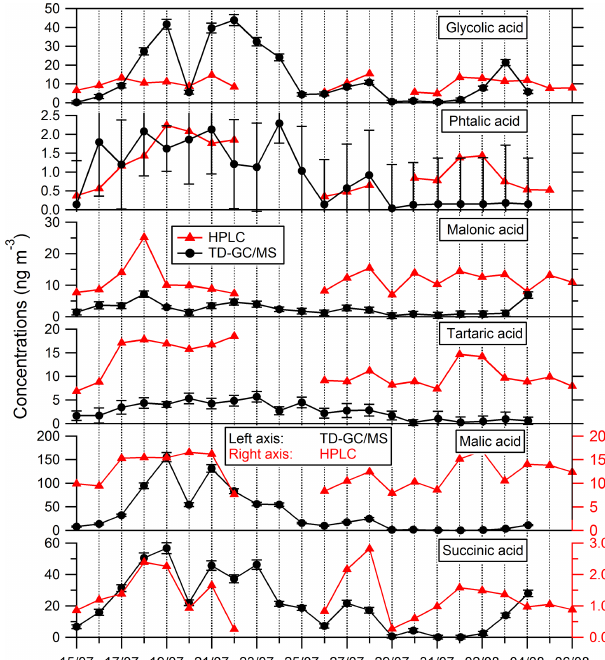
Figure 8. Comparison of ATD–GC–MS data with HPLC analysis for particulate glycolic acid, phthalic acid, malonic acid, tartaric acid, malic acid and succinic acid. Error bars correspond to the 1 σ uncertainties in TD–GC–MS